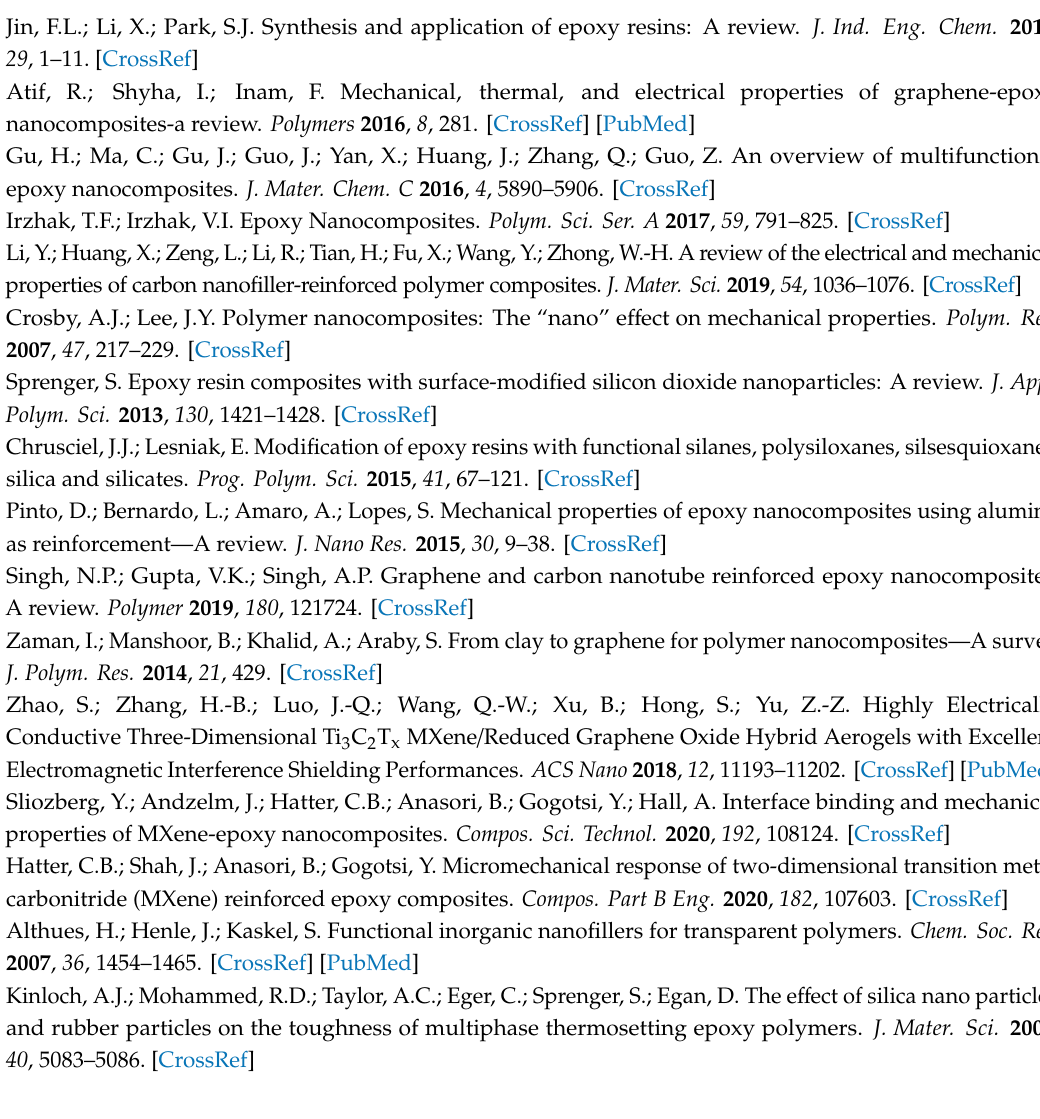
Supplementary Materials: The following are available online at http: // www.mdpi.com / 2571-9637 / 3 / 4 / 44 / s1, Synthetic details for the preparation of the coupling-agents, the nanoparticles, the surface-functionalization and the preparation of the nanocomposites, Figure S1: UV / VIS Spectra of 1.4 mm thick epoxy resin plates containing di ff erent nanoparticles, Figure S2: FT-IR spectra of phosphonic acids in pure state and after grafting onto ZrO 2 , Figure S3: FT-IR spectra of neat and organically surface modified 7.8 nm diameter SiO 2 nanoparticles, Table S1: Vickers hardness values (GPa) for epoxy resin nanocomposites with diol-end group organically modified silica and zirconia nanoparticles, Table S2: Glass transition temperatures of the epoxy resin nanocomposites from DSC for epoxy resin nanocomposites with diol-end group organically modified silica and zirconia nanoparticles, Table S3: Thermal decomposition onset temperatures of the epoxy resin nanocomposites from TGA for epoxy resin nanocomposites with diol-end group organically modified silica and zirconia